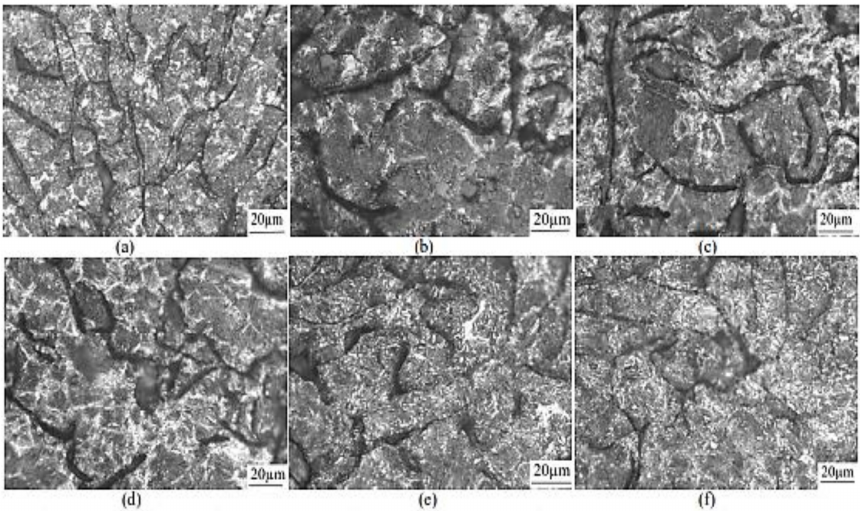
Figure 24. Microstructures of specimens for 1 h at different austempering temperatures: ( a ) 260 ◦ C,